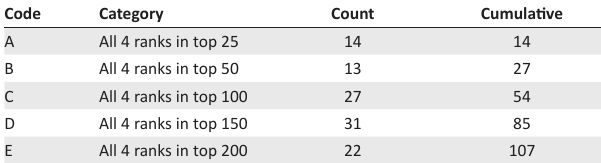
TABLE 10: Counts in contestant ranking categories within four analyses.